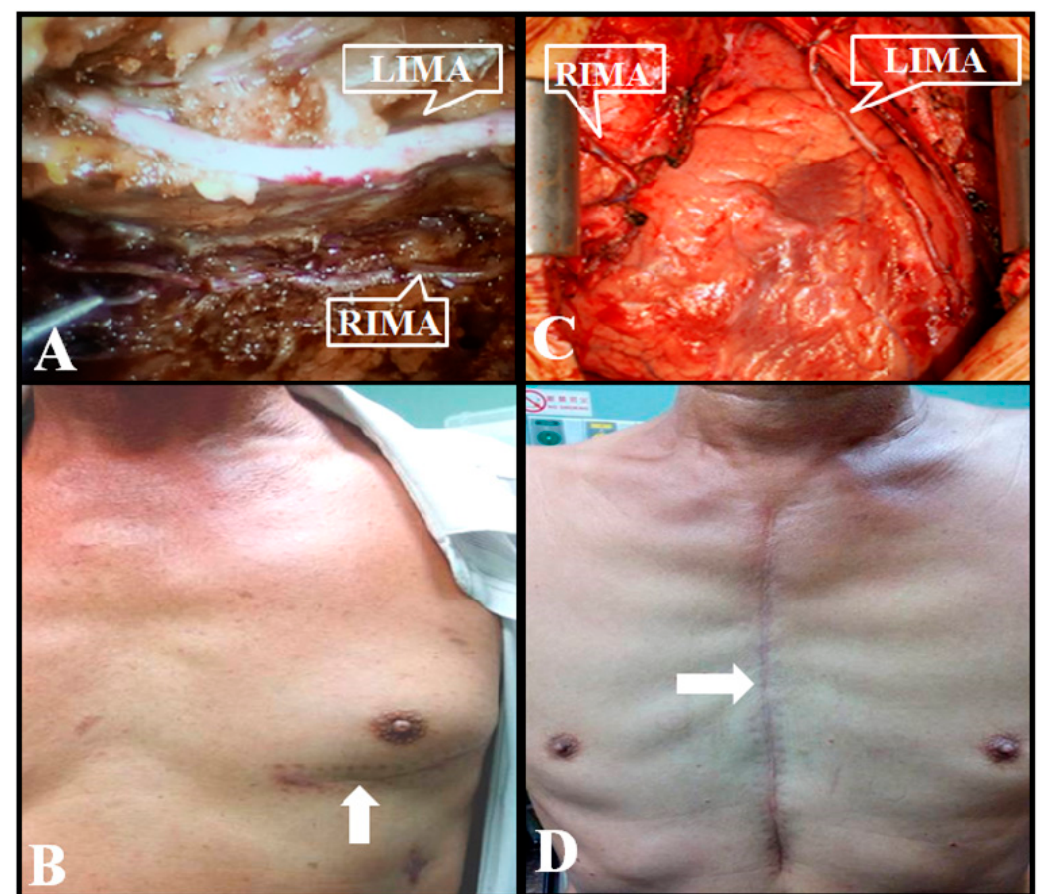
Figure 2. Wound healing in robotic and conventional sternotomy-assisted bilateral internal mammary artery grafting via the left pleura in coronary artery bypass grafting surgery. ( A ) Endoscopy shows that the left internal mammary artery (LIMA) (upper) and the right internal mammary artery (RIMA) (lower) were mobilized using the da Vinci operator system. ( B ) Surgical wounds (white arrows) of da Vinci robot-assisted CABG are small. ( C ) Finished anastomoses of LIMA (right) and RIMA (left) with coronary arteries are displayed in an explored sternal area of a sternotomy CABG. ( D ) A long mid-sternal wound scar (white arrow) is shown in a patient who had received a sternotomy CABG. Table 1. Baseline characteristics between two surgical modalities.